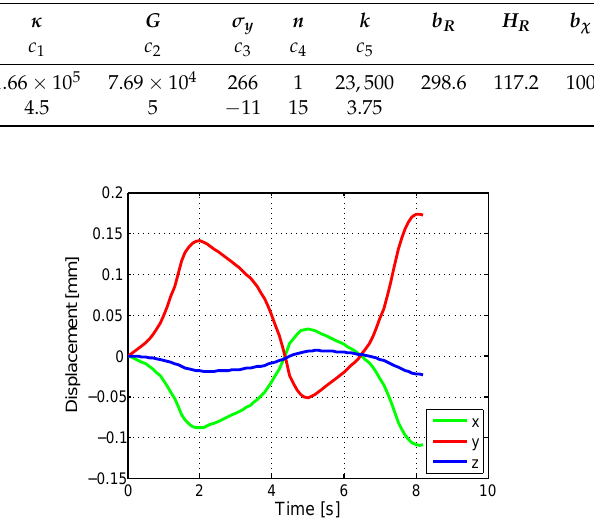
Figure 3. Displacement of point A in x , y and z directions according to